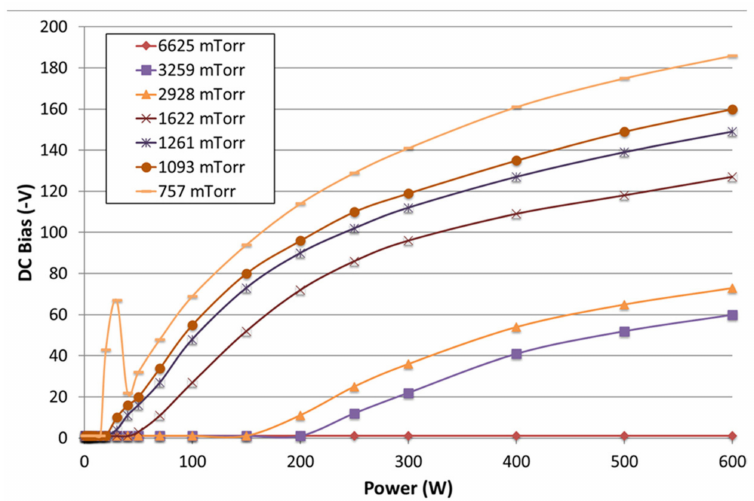
Figure 3. Measurements of the D.C. self-bias on the RF electrode at various RF power values using a nitrogen plasma. Note that the bias values are actually in negative